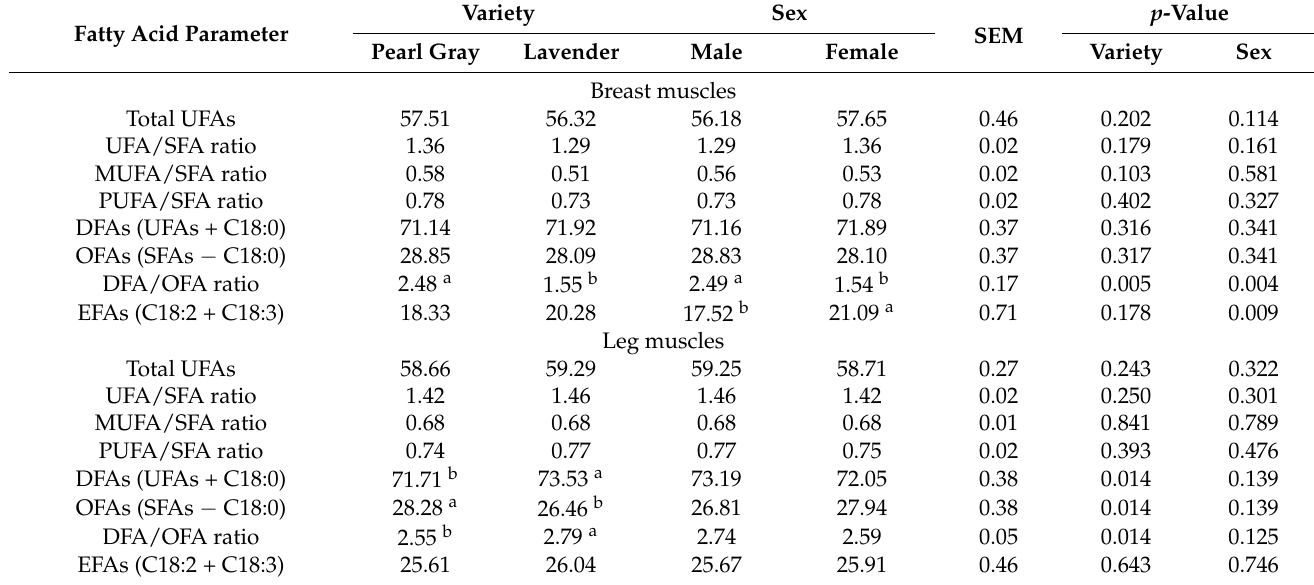
Table 9. Fatty acids profile of intramuscular fat (% of total fatty acids) in the breast and leg muscles of female and male guinea fowl of pearl gray and lavender varieties (means ±